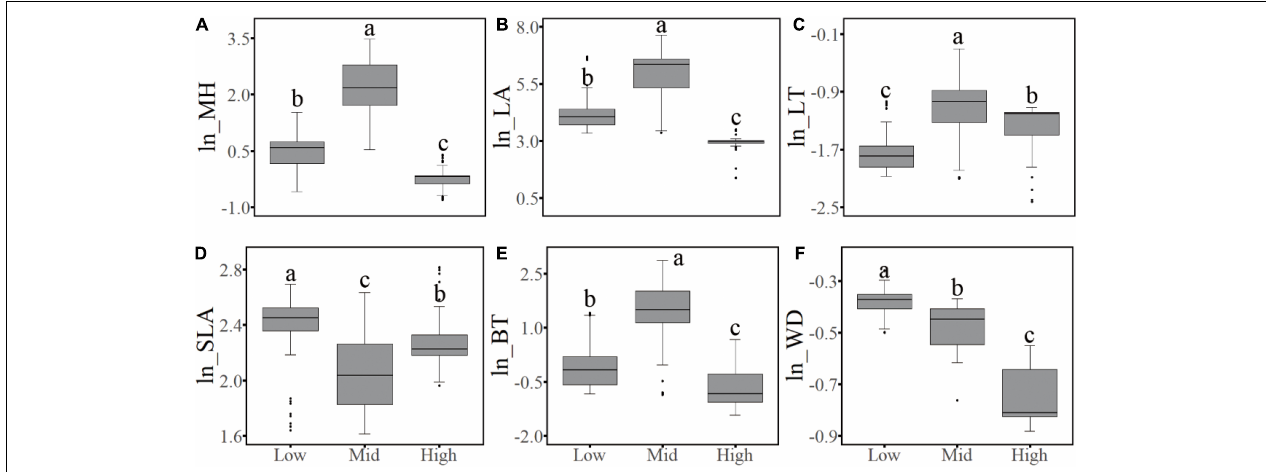
FIGURE 6 | Differences of the abundance-weighted community (log-transformed) mean value of functional traits in different vegetation types on two aspects of the mountain. Low, shrubs at low elevation; Mid, forests at middle elevations; High, alpine shrubs and meadow. (a–c) Indicate different levels among three sections with statistical significance. (A–F) Corresponds to the conditions of six plant functional